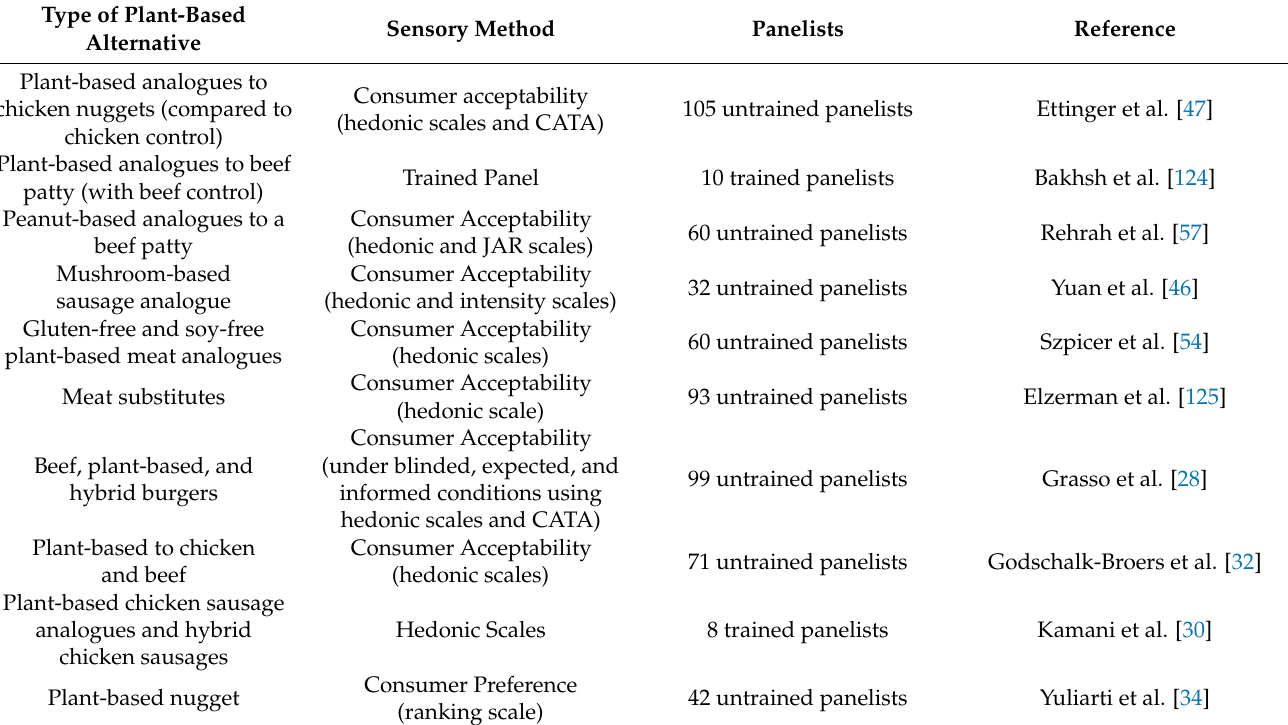
Table 2. Examples of the different studies investigating sensory properties of plant-based